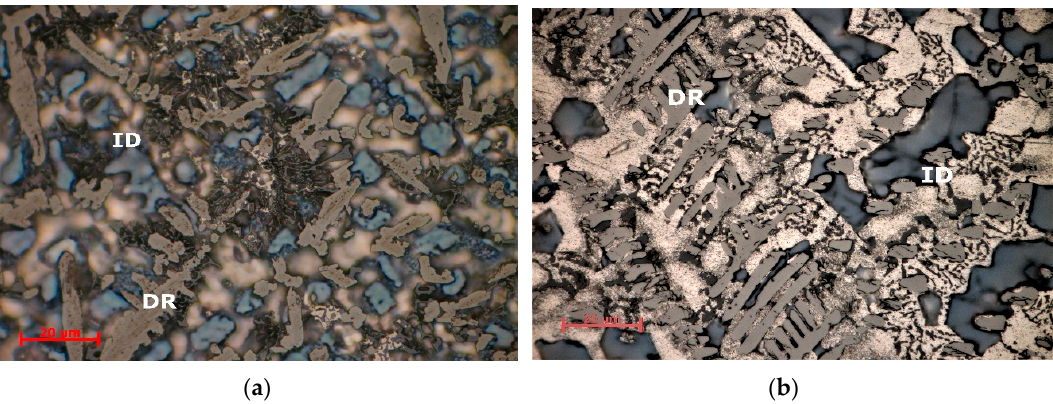
Figure 13. Optical micrographs of ( a ) as-cast and ( b ) annealed cast Al 3 Mn 0.2 Zn 0.3 Mg 0.7 Si 0.8 alloy. DR—dendritic area; ID—interdendritic area.